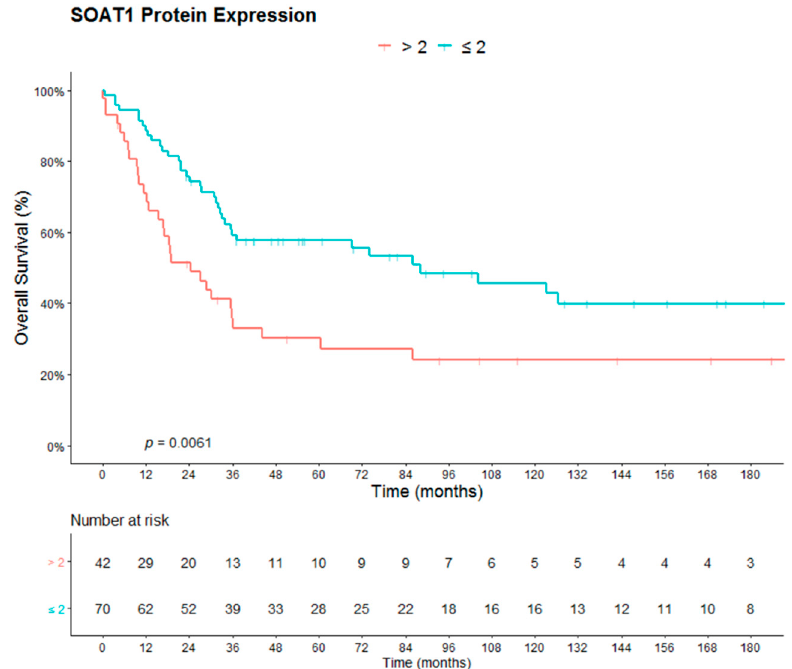
Figure 2. Impact of SOAT1 protein expression on overall survival in 112 adult patients with ACC (tumor samples derived from primary surgery).